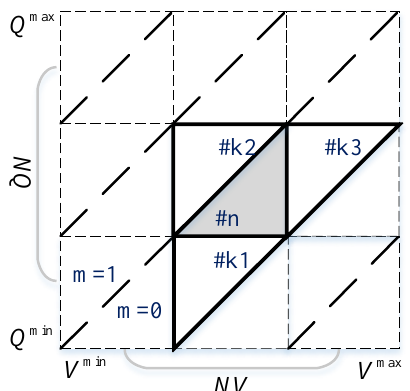
Figure 1. Triangulation of the domain of the power output function.